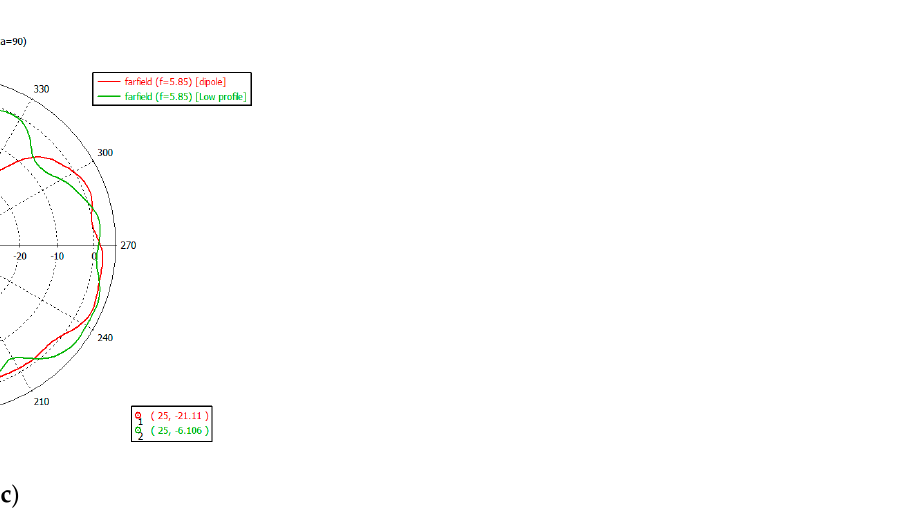
Figure 9. Characterization results of beam patterns radiated from WAVE antenna with/without quadruple closed-loop devices. Red and black colors denote simulation results obtained from the